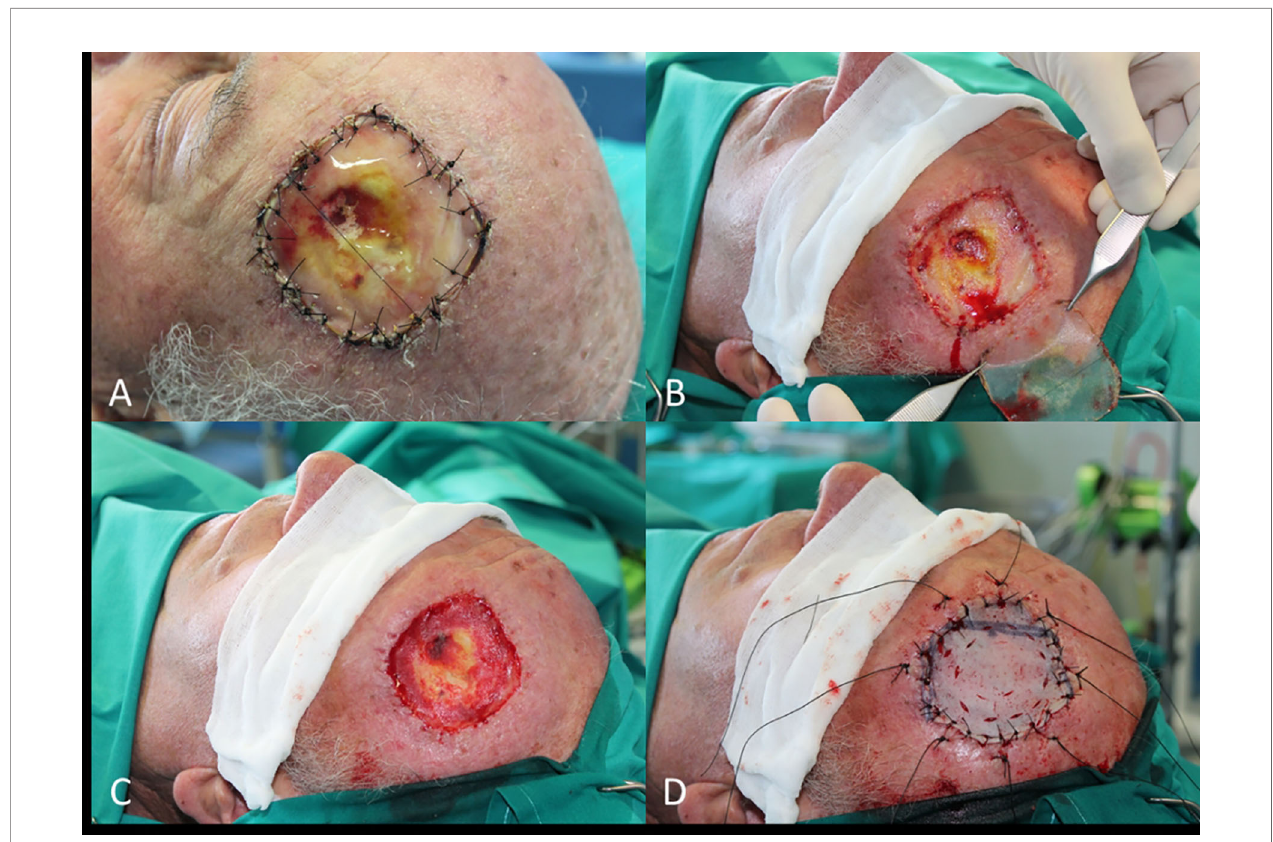
FIGURE 3 | (A) Reconstruction of scalp after WLE and regenerate template application; (B) Removal of silicone patch; (C) Wound bed debridement; (D) Final closure with skin